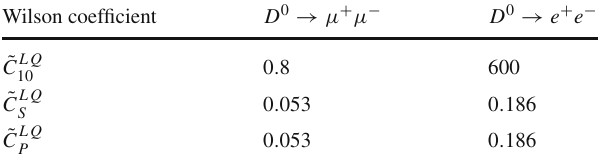
Table 1 The allowed values of the Wilson coefficients obtained from the upper bound of the process D 0 → μ + μ − ( e + e − ) . The constraint on the ˜ C LQ coefficients can also be applicable to ˜ C i Wilson